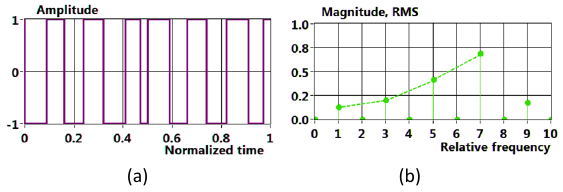
Fig.11: BMS (a) and its magnitude spectrum (b) with rising levels of components (frequency bins 1, 3, 5, 7).